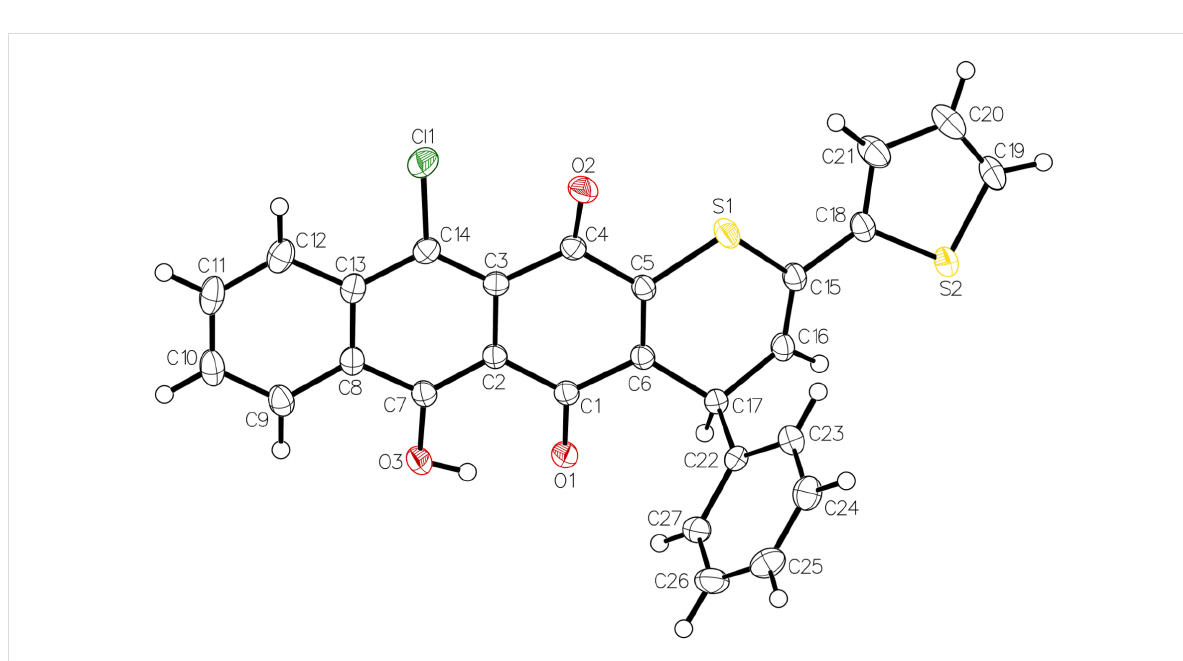
Figure 1: ORTEP plot [29] of the molecular structure of 4k showing the major conformation of the disordered thiophene ring (50% probability ellip- soids; arbitrary numbering of the atoms).